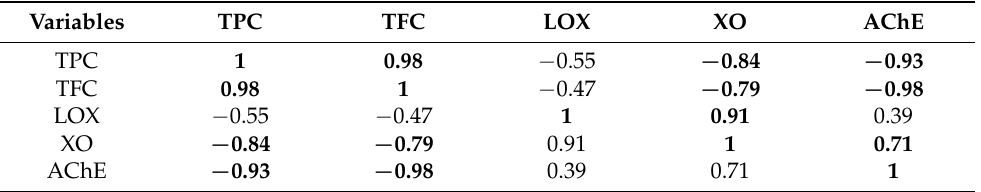
Figure 8. Biplot for fennel plants grown in the presence of Fe (+Fe) or in the presence of Fe plus bicarbonate (+Fe +Bic) between inhibitory enzymes and total pool phenolics. Table 1. Correlation coefficients between total phenolic content (TPC)/total flavonoid content (TFC) and the IC 50 values for LOX, XO and AchE